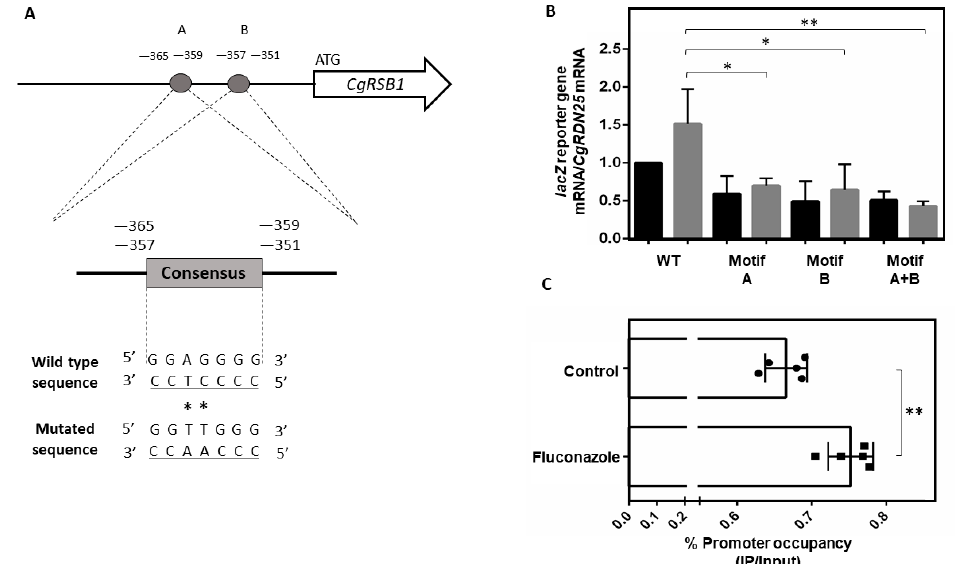
Figure 5. Possible CgMar1 DNA binding sites and association at the CgRSB1 promoter. ( A ) The putative CgMar1 recognition sequences in the promoter of CgRSB1 are in the complementary stand. The numbers refer to the position of the consensus site relative to the first ATG of the coding region. The wild-type sequence is shown underlined, with asterisks denoting the base substitutions generated by site-directed mutagenesis. The resulting mutated sequence is shown below. ( B ) Comparison of the variations of lacZ transcript levels determined by RT-PCR in KUE100::URA- C . glabrata cells harboring the pYEP354_ CgRSB1 prom_lacZ (wild-type promoter) or pYEP354_mutA/B/A+B_ CgRSB1 prom_lacZ (mutated promoters) plasmids under control conditions or after 1 h of fluconazole exposure. Transcript levels of CgRDN25 were used for normalization. The black bars refer to control conditions, and the grey bars refer to fluconazole exposure. Expression values are the averages from at least three independent experiments. The error bars represent the corresponding standard deviations. ( C ) ChIP-RT-PCR measurements of CgMar1 promoter occupancy at the CgRSB1 promoter region containing the possible recognition motifs. ChIP experiments were performed using mouse anti-GFP antibody and cultures of KUE100::URA- C . glabrata cells harboring the pGREG576_PDC1_ CgMAR1 plasmid under control conditions or after 1 h of fluconazole exposure. The amplified amount of DNA was measured by RT-PCR and normalized to the total amount of the sample. Samples from the CgMar1 IP were compared to the input (IP/Input) under each condition. To determine percent occupancy, values were calculated as the ratio of the percent precipitated under fluconazole stress to the percent precipitated under control conditions. Promoter occupancy values are the averages from at least three independent experiments. Error bars represent the corresponding standard deviations. * p -value < 0.05, ** p -value < 0.01.